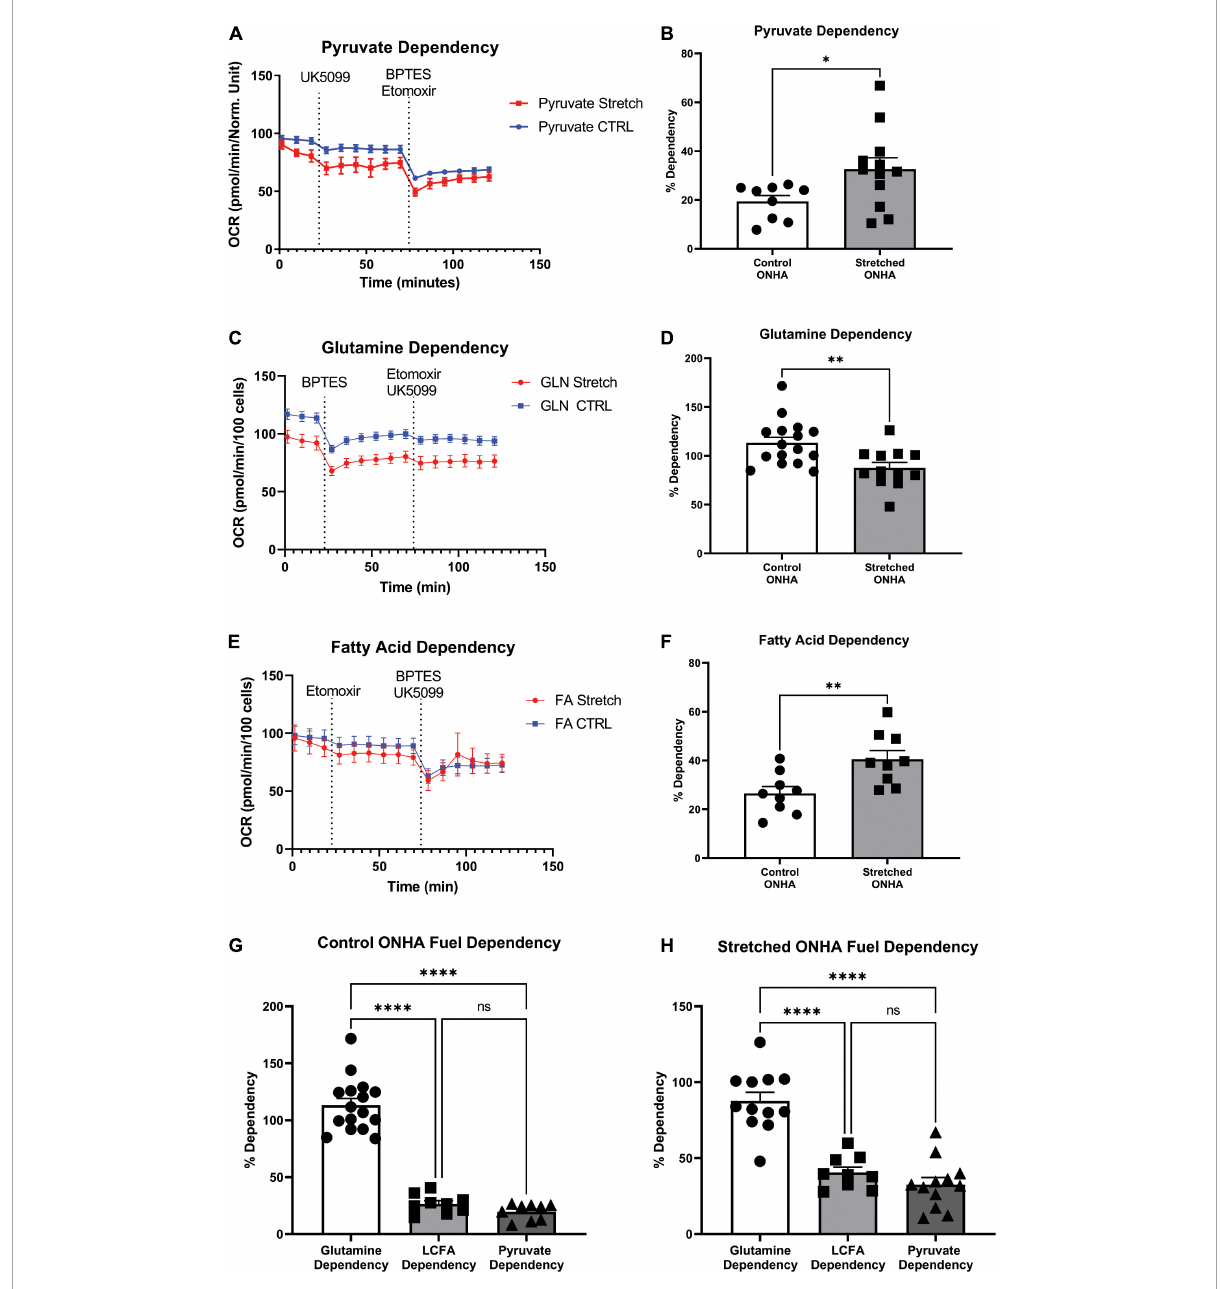
FIGURE4 Mitochondrial substrate dependency of optic nerve head astrocytes (ONHAs) is changed by glaucomic stretch . (A) Representative oxygen consumption rate (OCR) output for the pyruvate dependency test. Cells are exposed to the mitochondrial pyruvate carrier inhibitor UK5099 followed by the glutamine and fatty acid oxidation pathway inhibitors BPTES and Etomoxir, respectively. (B) OCR for pyruvate dependency is significantly higher for stretched ONH astrocytes compared to Control (* p = 0.0347, n = 20). (C) Representative oxygen consumption rate (OCR) output for the glutamine dependency test. Cells are exposed to the glutaminase inhibitor BPTES followed by the fatty acid oxidation and pyruvate pathway inhibitors Etomoxir and UK5099, respectively. (D) Glutamine dependency is significantly lower in Stretched ONH astrocytes compared to Control (** p = 0.0052, n = 27). (E) Representative OCR output for the fatty acid dependency test. Cells are exposed to the carnitine palmitoyl-transferase 1a inhibitor Etomoxir followed by the glutamine and pyruvate pathway inhibitors BPTES and UK5099, respectively. (F) Fatty acid metabolic dependency is significantly higher in Stretched compared to Control ONH astrocytes (** p = 0.0071, n = 17). (G) Control ONHA fuel dependency is significantly different by one-way ANOVA ( p < 0.0001). Control ONH astrocytes are significantly more dependent on glutamine as compared to fatty acids (**** p < 0.0001) or pyruvate (**** p < 0.0001) for fuel. These control ONH astrocyte data are the same as in panels (B–F) , collected together for ease of comparison. (H) Stretch ONHA fuel dependency is significantly different by one-way ANOVA ( p < 0.0001). Stretched ONH astrocytes are also significantly more dependent on glutamine as compared to fatty acids (**** p < 0.0001) or pyruvate (**** p < 0.0001) for fuel. These stretch ONH astrocyte data are the same as in panels (B–F) , collected together for ease of